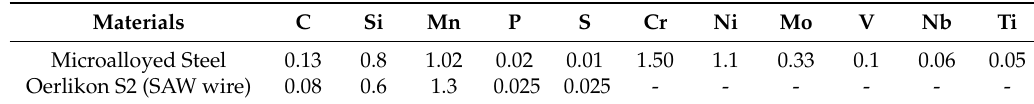
Table 1. Chemical compositions of test materials.